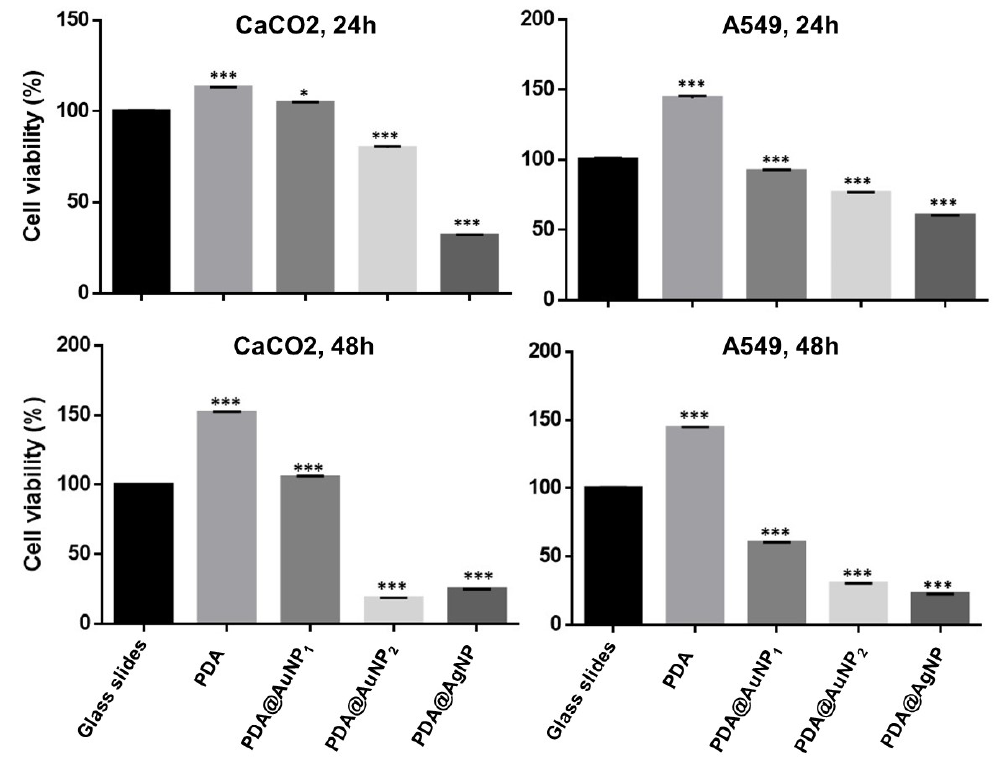
Figure 5. MTT assay of CaCO2 and A549 cells onto different surfaces after 24 and 48 h of cell culture. The number of asterisks indicates the significance of the alterations in the cell viability.